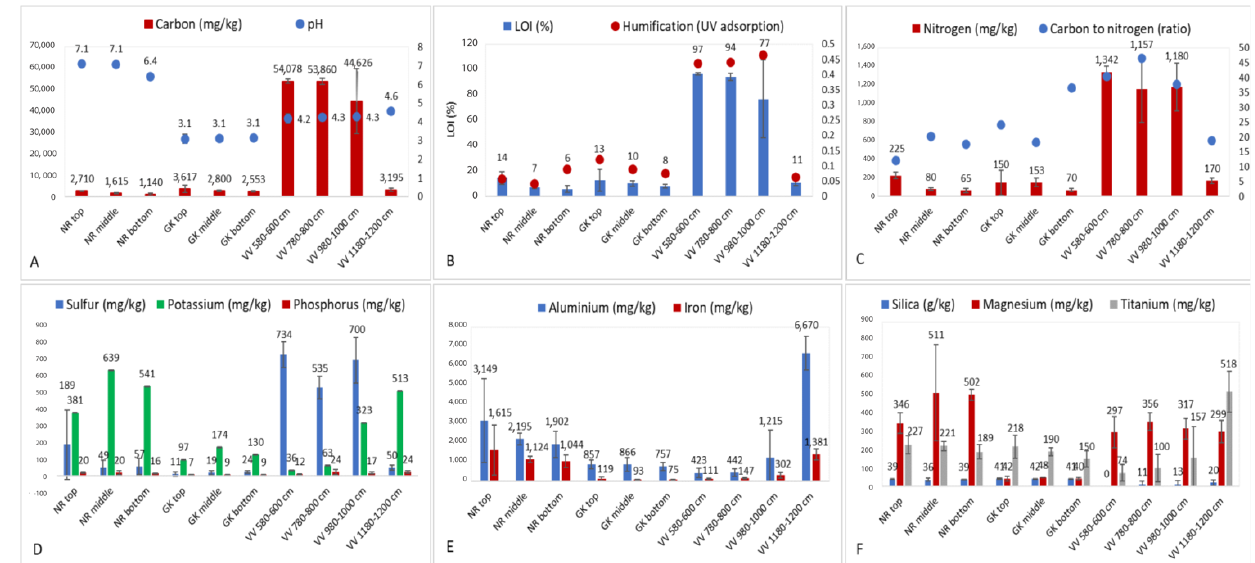
Figure 7. Measured parameters determined by BEST analyses to be the most important drivers of actinobacterial and/or fungal community structure ( A – F ) and pH ( A ) in samples taken from the study sites at different depths. LOI: loss on ignition. NR = Nuwejaars River system (developing peatland); GK = Goukou River system (impacted peatland); VV = Vankervelsvlei (undisturbed peatland). Top: samples from 0 to 5 cm depth; middle: samples from 25 cm depth; bottom: samples from 50 cm depth.